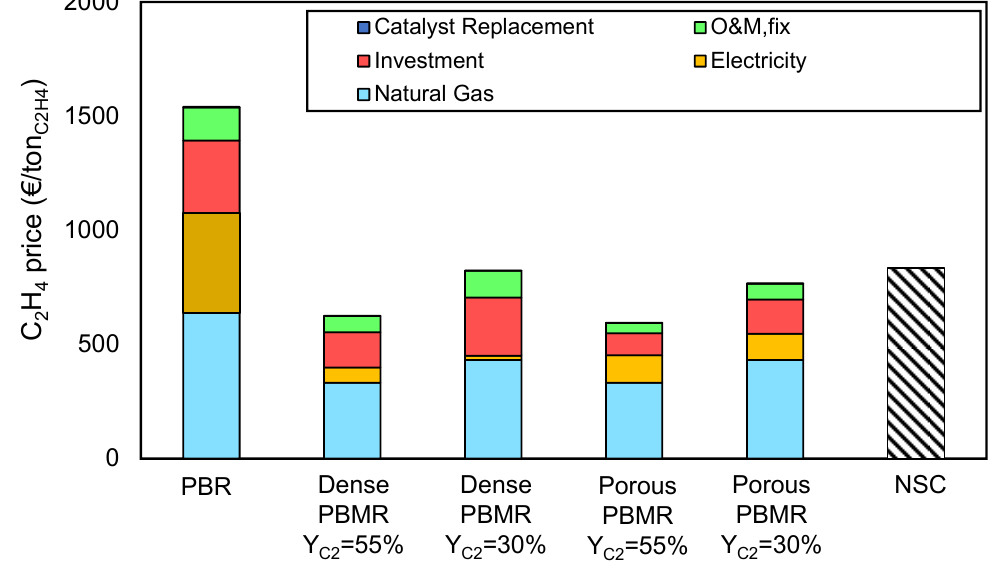
Figure 7. Cost distribution of the OCM process when using four di ff erent reactor configurations; packed bed (PBR), dense membranes reactor, dense membranes reactor with a reduced yield, porous membranes reactor and porous membranes reactor with a reduced yield, and of the conventional naphtha steam cracking